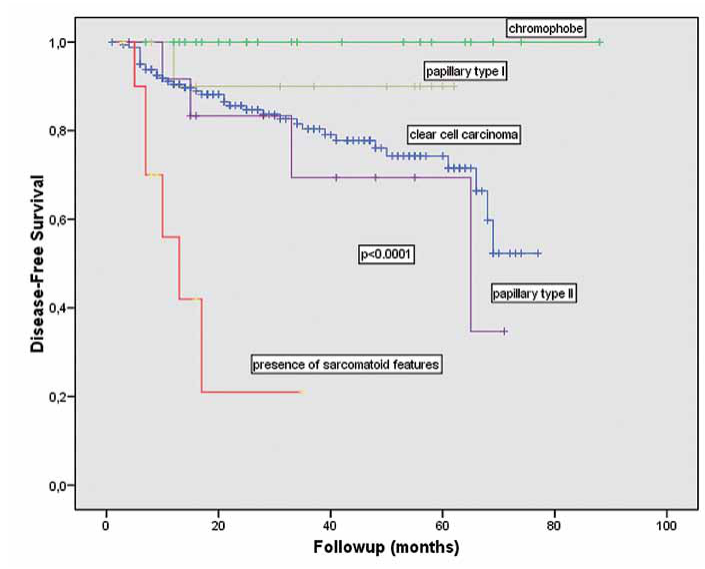
Figure 1 - Rate of disease-free survival after 5 years according to the various histological subtypes. The higher percentage of survival occurred in patients with chromophobe tumors and lower survival rate in patients with sarcomatoid features. (Kaplan-Meier log rank test p < 0.0001).